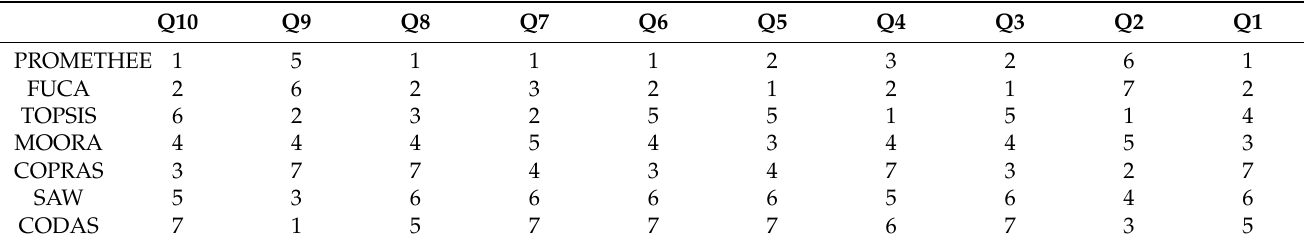
Table 10. Performance Ranking of MCDM Methods according to Spearman’s Rho.